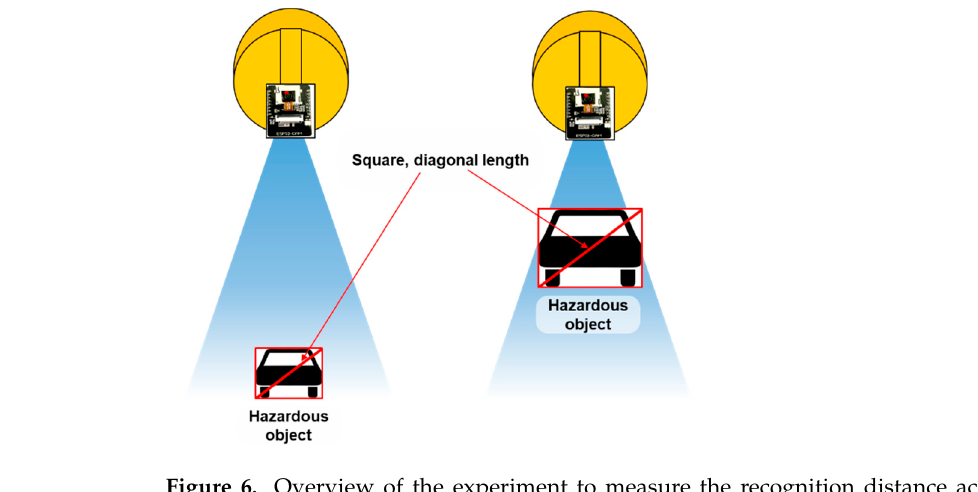
Figure 6. Overview of the experiment to measure the recognition distance according to input minimum diagonal length.